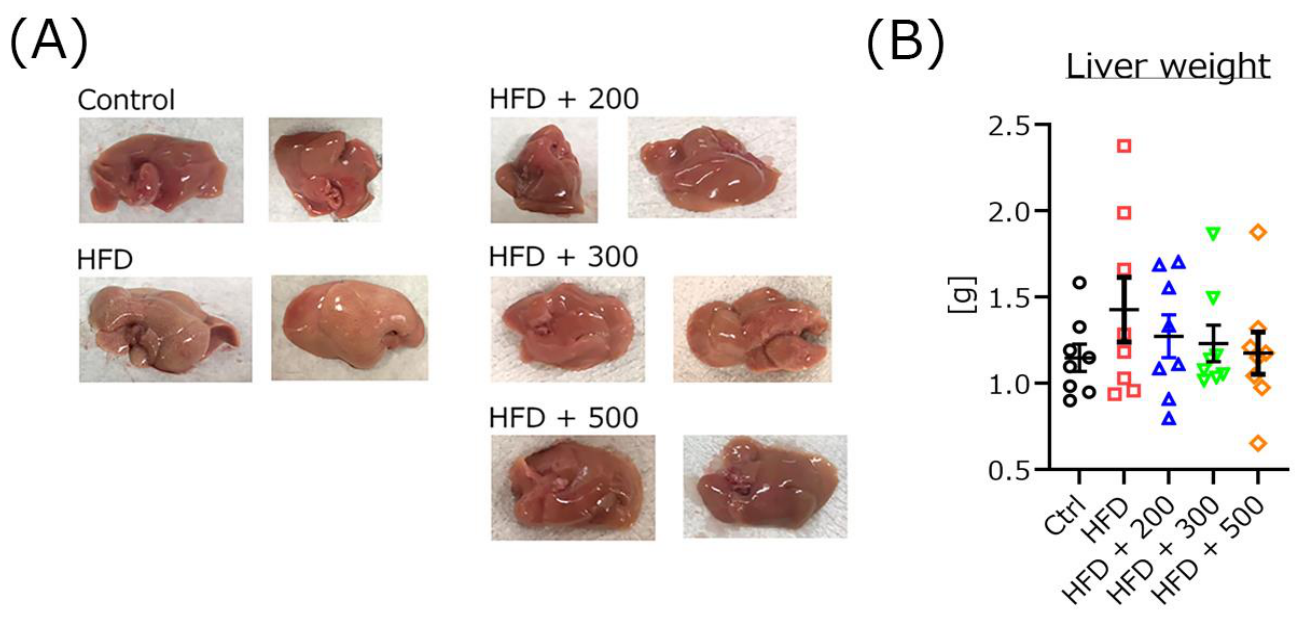
Figure 6. Livers removed after treatment. Liver images ( A ). Control (Ctrl), high-fat diet (HFD), HFD + DSW-extract-added water hardness 200 (HFD + 200), HFD + DSW-extract-added water hardness 300 (HFD + 300), HFD + DSW-extract-added water hardness 500 (HFD + 500). The liver weight of each mouse group ( B ). ( n = 8, respectively) There were no significant differences among all groups. The data are shown as means ± SE. Comparisons were performed using the Tukey-Kramer method.